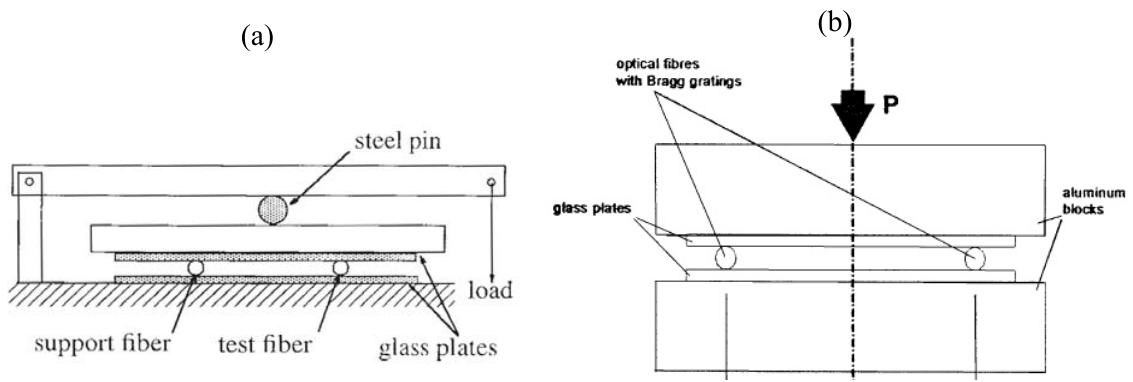
Figure 5. (a) Calibration device using a leverage arm to load the FBG and the